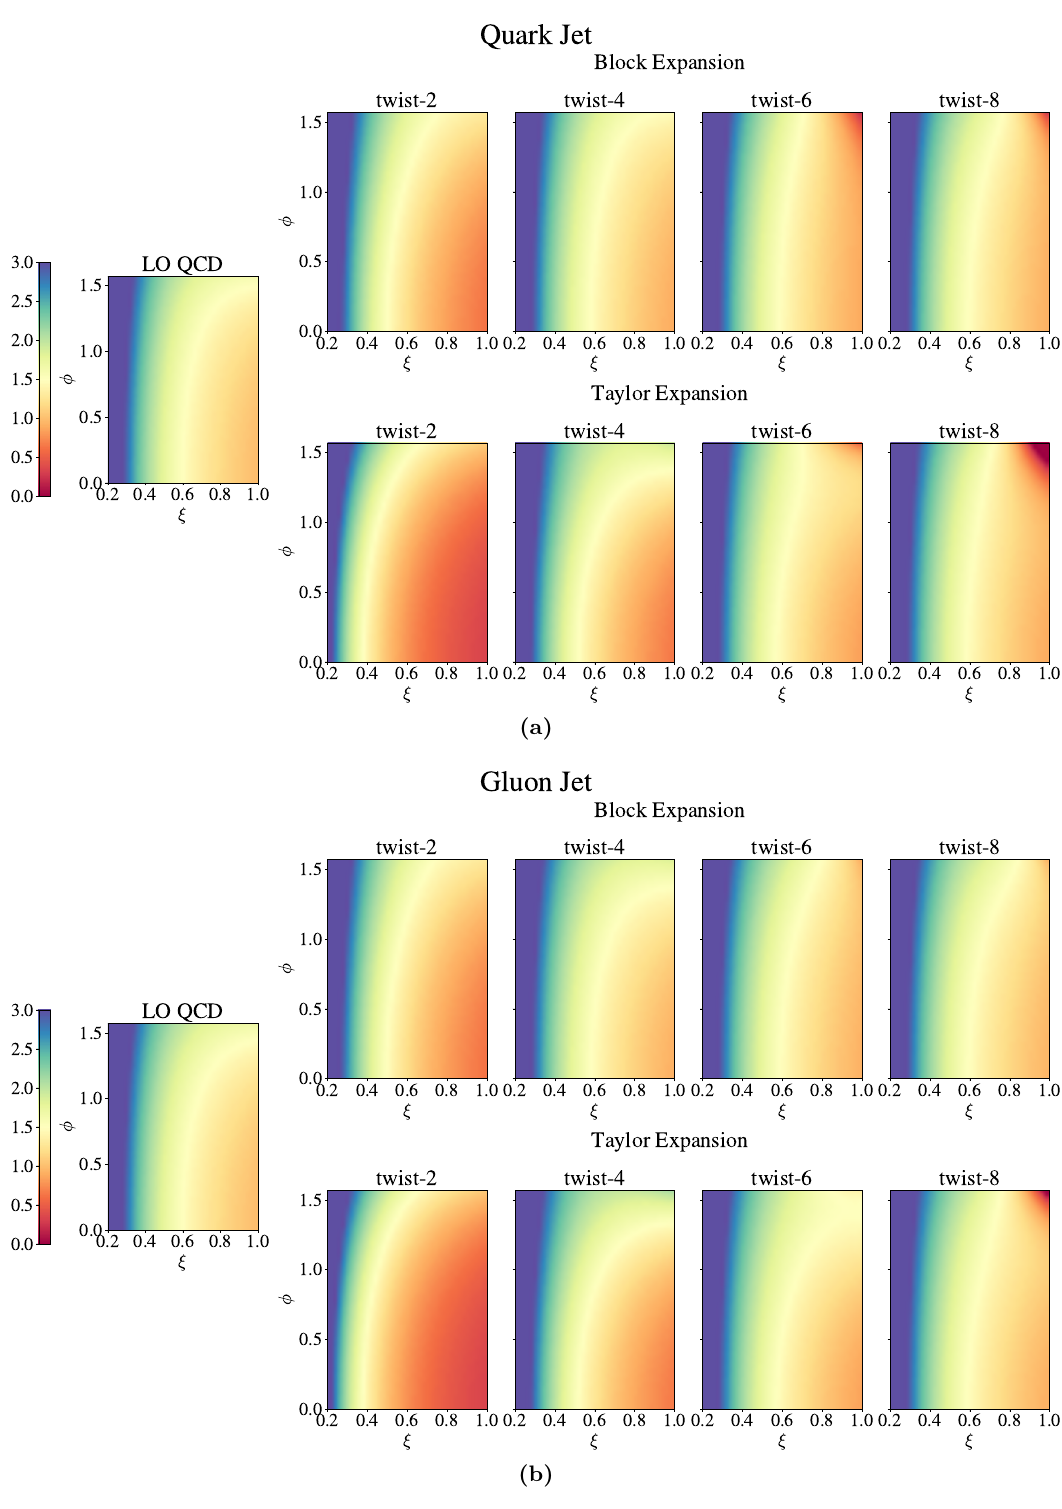
Figure 12. The leading order shape dependence of the three-point correlator for quark jets (a) and gluon jets (b), compared with the expansion in terms of celestial blocks and the naive Taylor expansion about the OPE